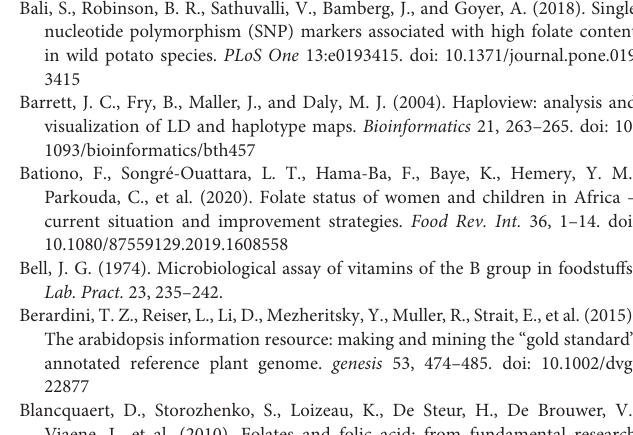
Supplementary Figure 3 | Quantile-quantile plot showing goodness of fit of the three tested models. The plot in panel (A) represents data from 2015, and the plot in panel (B) is based on data from 2016. The GLM model is colored in blue, the MLM model is colored in green, and the FarmCPU model is colored in fuchsia. Supplementary Figure 4 | Synteny analysis of the Pv 11FLT1 QTL. Each panels (A–D) represents a physical map of a chromosome region containing one or more seed folate content QTL. Green glyphs depict gene structures. Glyphs above or below the dashed line in each panel are in the forward or reverse orientations, respectively. Black or red vertical lines above glyphs represent high scoring pairs (HSP) from a BLAST search, and the HSPs are connected by red lines. The QTL are represented by blue bars, and the names correspond to the cited references. In parentheses, each QTL name is followed by its physical map position in Mb. The analysis was conducted in GeVo, and the following genome builds are identified based on their numerical IDs in the CoGe database (Lyons and Freeling, 2008). (A) O. sativa Indica Group Chr. 3 (Genome ID 51124) from 22,400,170 to 38,914,741 bp. QTL were identified in Dong et al. (2014). (B) Z. mays Chr. 5 (Genome ID 52733) from 955,126 to 21,448,993 bp. QTL were identified in Guo et al. (2019). (C) Z. mays Chr. 5 from 2,345,700 to 2,447,356 bp (Genome ID 52733). (D) P. vulgaris Chr. 11 (Genome ID 37644) from 5,602,110 to 5,987,842 bp. QTL ( Pv 11FLT1) was identified in the present work. Mb, megabase pairs; K, kilobase pairs. Supplementary Table 1 | P. vulgaris lines and varieties used in this study and their seed folate contents. K groups, QTL marker genotypes, and folate contents (least squared means) from the 2015, 2016, and combined ANOVAs are reported. Supplementary Table 2 | Filtering of SNP markers used in this study. Data were filtered using VCFtools. Phasing and imputation of missing data was performed with BEAGLEv4.1. LD was estimated between SNPs based on the r 2 function in PLINK, and pairwise LD was determined between markers within a sliding window of 50 SNPs. Within the window, all but one SNP among groups of SNPs with high LD ( r 2 > 0.95) removed. The final set of 2,522 SNPs were used for GWAS. Hets, heterozygous SNPs; MAF, minor allele frequency. Supplementary Table 3 | Candidate genes within haplotypes for total seed folate content QTL identified by GWAS. GeneIDs from and their annotations in the P. vulgaris genome build v2.1 were obtained from Phytozome (Goodstein et al., 2012). Supplementary Table 4 | Candidate genes in syntenic genomic regions of seed folate QTL in Z. mays , O. sativa , and P. vulgaris . A, CoGe Synmap was used to identify syntenic regions, and regions that contained QTL among all of the cited studies are reported. QTL names match the designations in the respective references (Lyons et al., 2008). B, List of candidate genes that were present in all syntenic groups from panel (A) . Gene IDs follow nomenclature from the CoGe